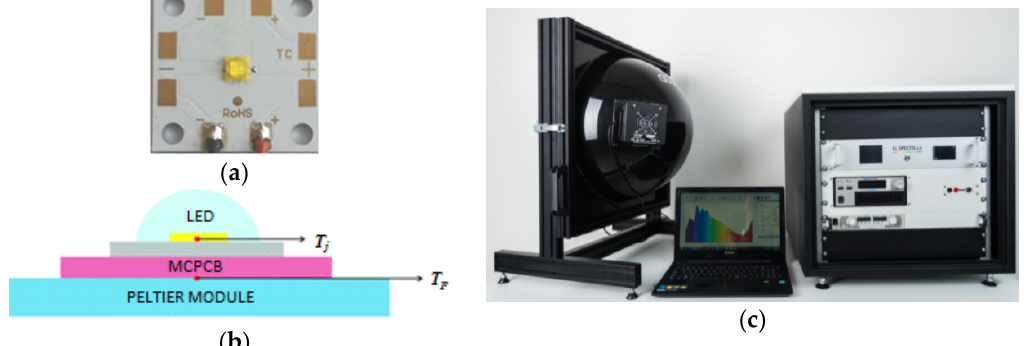
Figure 2. The studied LED source ( a ), characteristic temperatures ( b ) and test stand of the GL Optic Company ( c ).